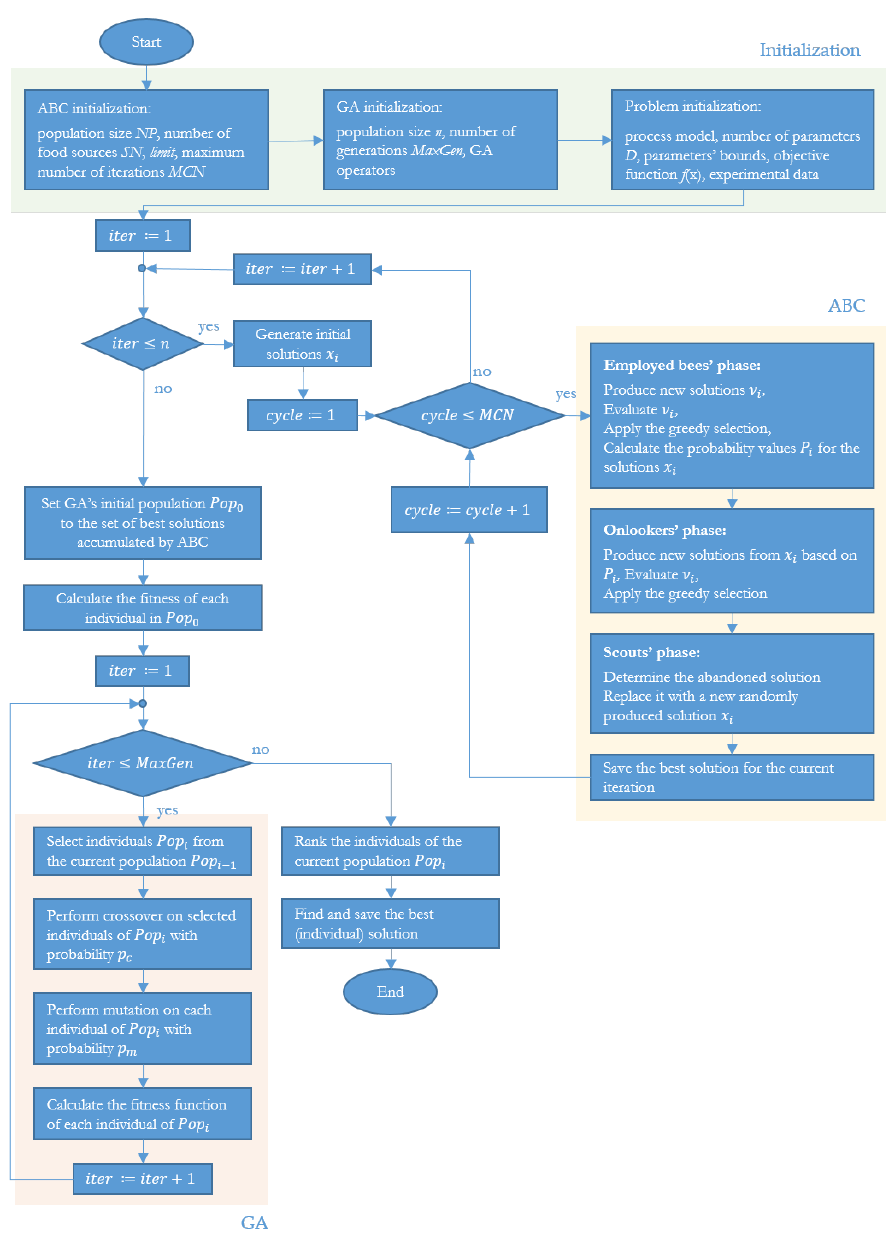
Figure 1. Block scheme of ABC-GA hybrid algorithm.